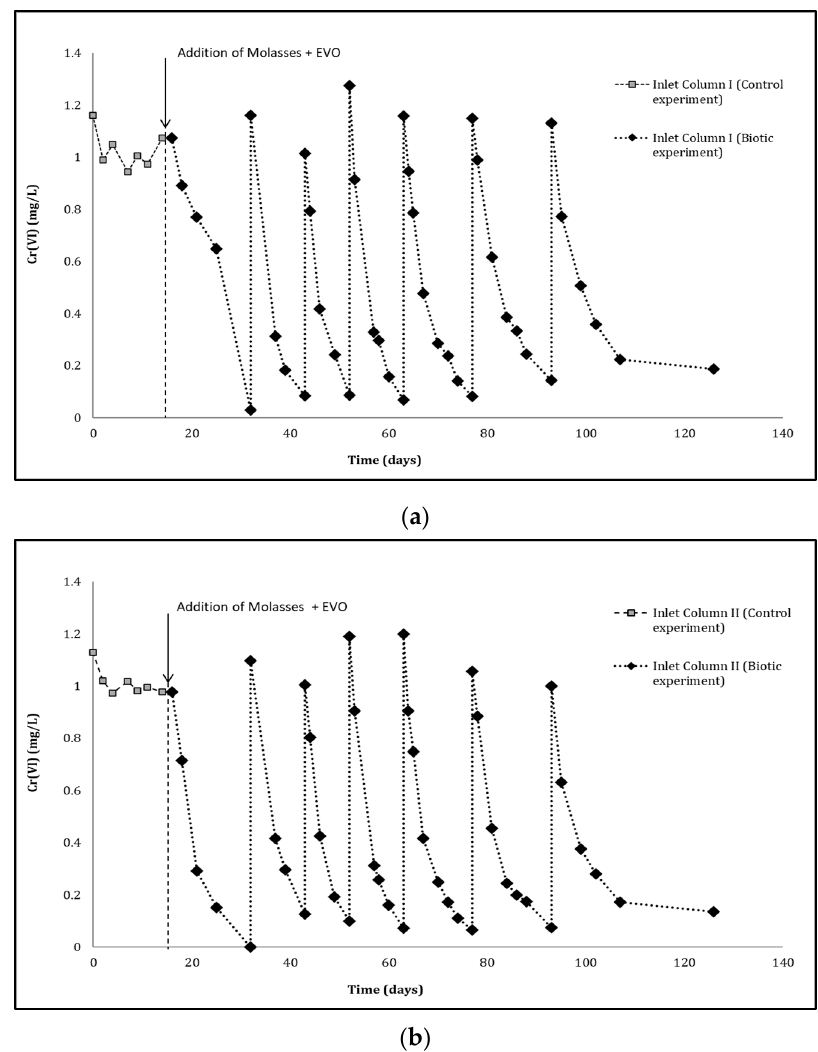
Figure 2. Cr(VI) profiles in the inlet of Columns I ( a ) and II ( b ) during the control and bio-enhancement experiments.